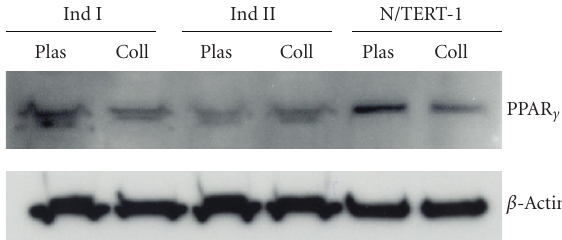
Figure 1: PPAR γ expression by immunoblot in PHKs. 40 μ g cellular protein isolated from PHKs from two di ff erent individuals was grown on tissue culture plastic coated with (Coll) and without (Plas) type I rat tail collagen. Protein from telomerase-immortalized primary human keratinocytes (N/TERT-1) was also utilized. In all cases, the proteins were separated on a 10% SDS-PAGE and PPAR γ protein was detected using a monoclonal anti-PPAR γ antibody. Loading was verified by stripping the blots and performing an immunoblot for β